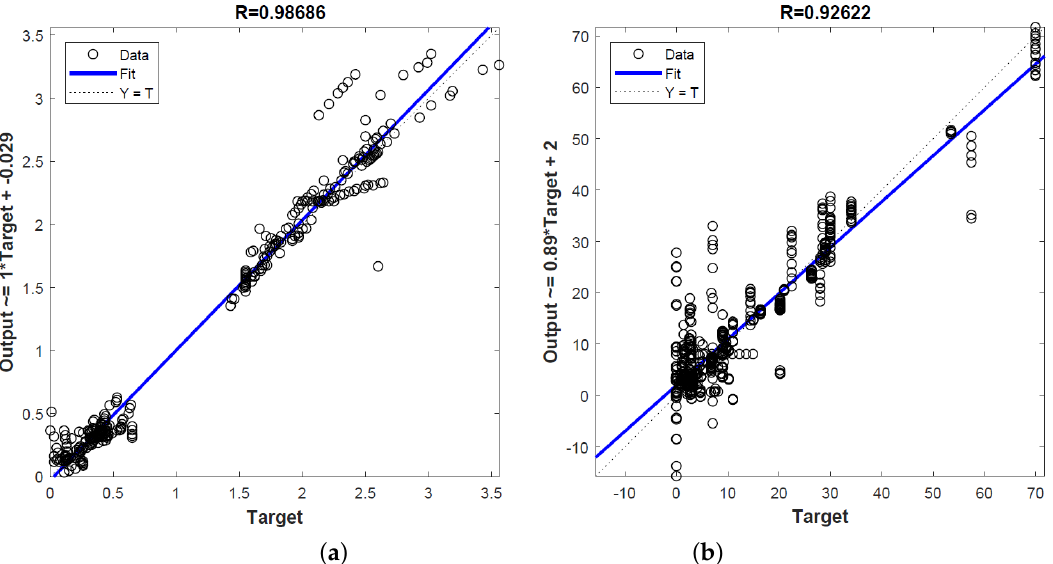
Figure 7. Comparison between the ANN predictions and the target values (experimental data) for the two models using the 159 data points from the database initially set aside: ( a ) Case 1 and ( b ) Case